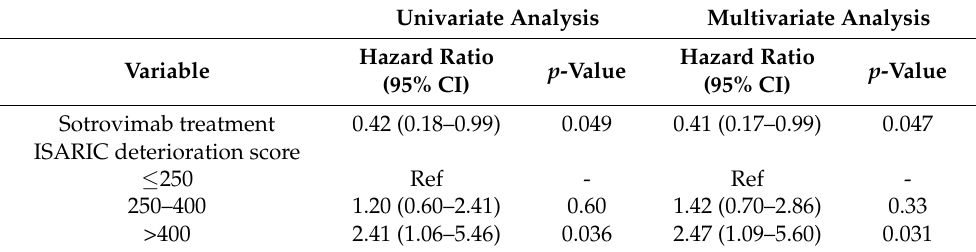
Figure 2. Kaplan–Meier curve of time to in-hospital deterioration (composite outcome of O 2 require- ment, ICU admission, or death). Table 2. Cox proportional hazards model for in-hospital deterioration.